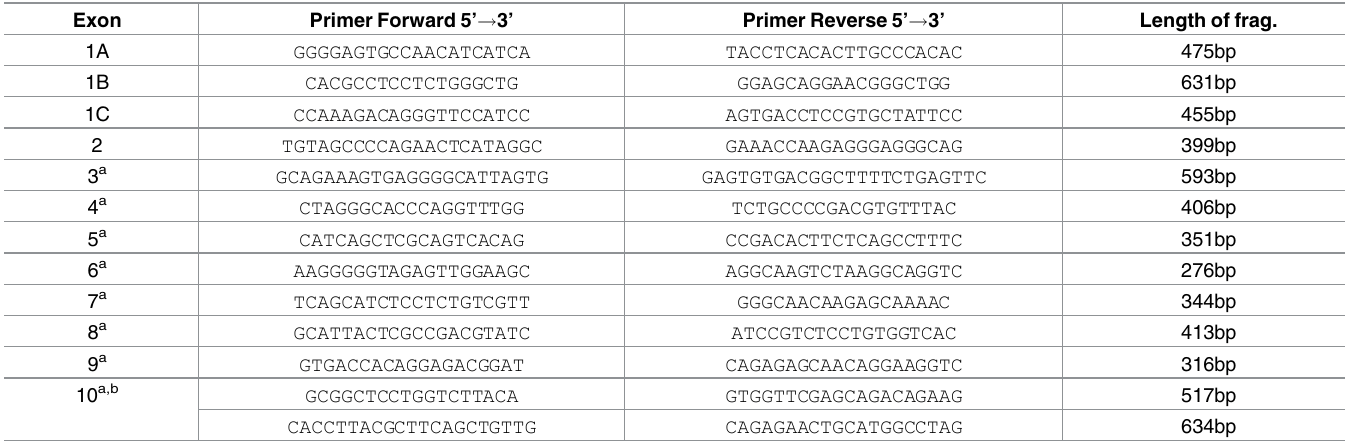
Table 1. Primers used in sequencing